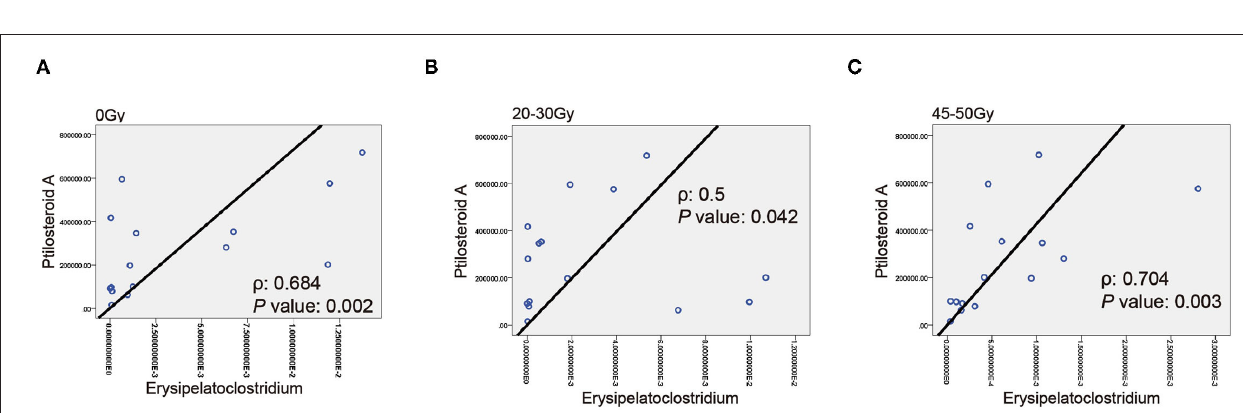
been well-investigated. Therefore, gut metabolite ptilosteroid A may contribute to the etiology of RIII, and serve as potential biomarker for